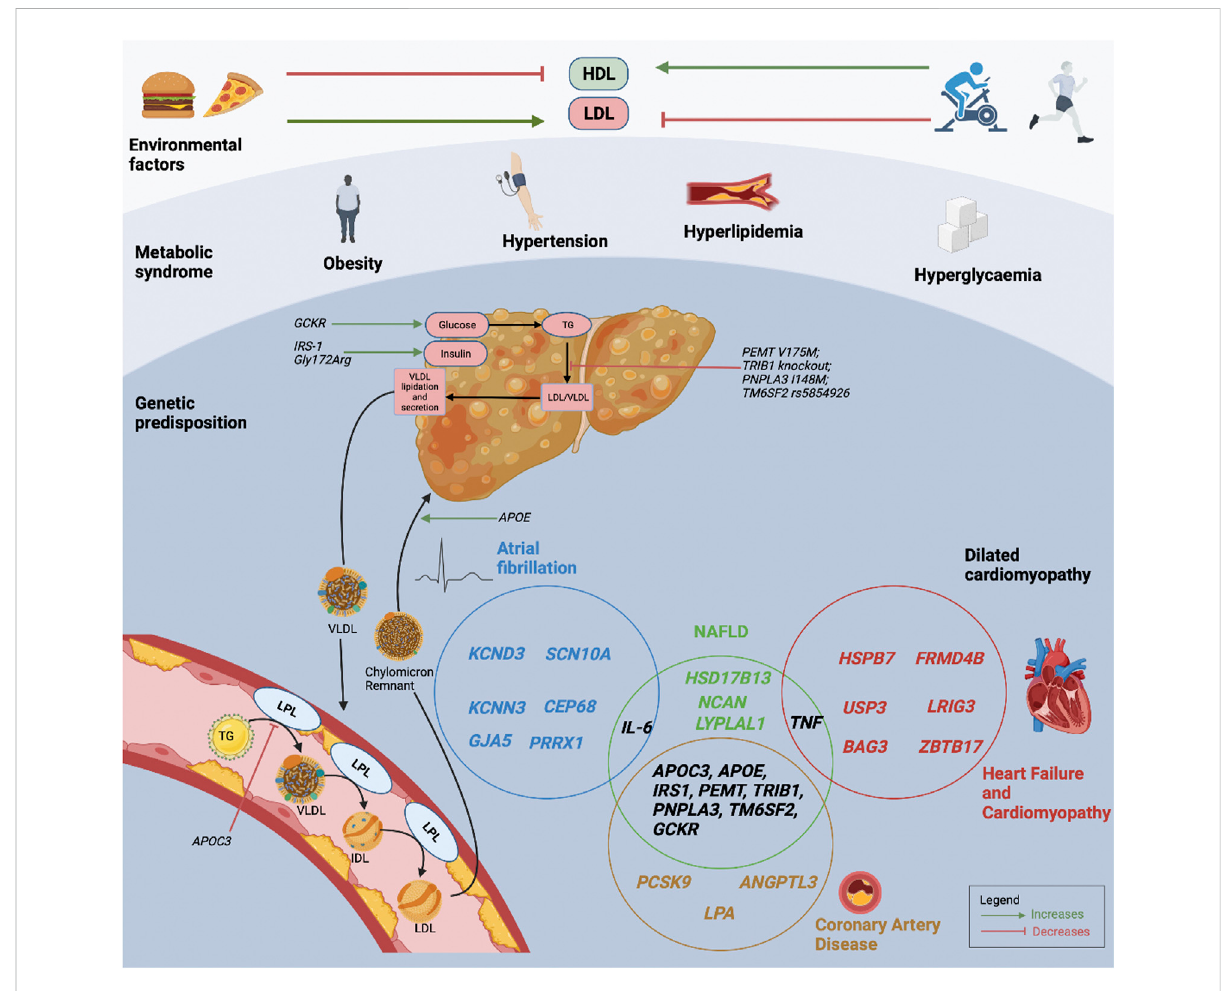
FIGURE 1 Interactions between environmental factors, metabolic pro fi les, and an individual ’ s genetic predisposition for NAFLD and CVD. The Venn diagram demonstrates the interactions between NAFLD and CVD susceptibility genes. HDL, high-density lipoprotein cholesterol; LDL, low-density lipoprotein cholesterol; LPL, lipoprotein lipase; NAFLD, non-alcoholic fatty liver disease; TG, triglyceride; VLDL, very low-density lipoprotein